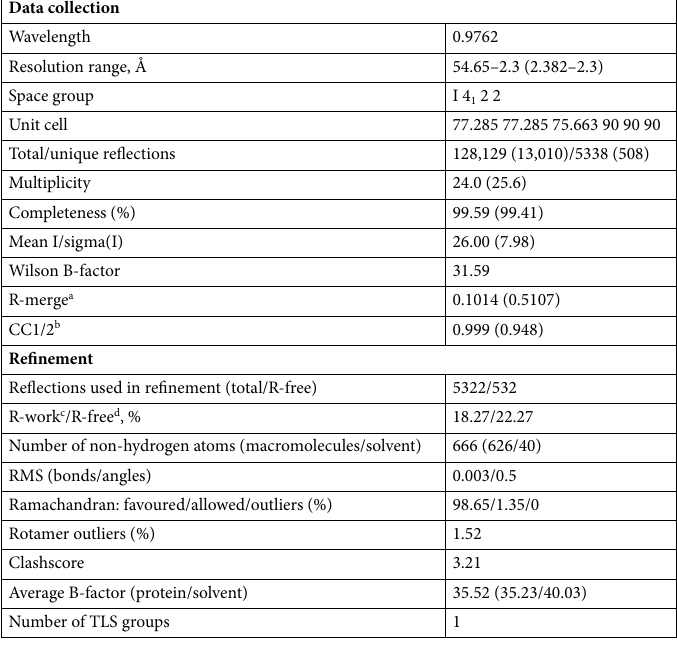
Table 1. Data collection and refinement statistics. Data collection statistics for the highest-resolution shell are shown in parentheses. a R merge = � hkl (cid:31) i | I i ( hkl ) − � I ( hkl ) �| / (cid:31) hkl (cid:31) i I i ( hkl ) , where I i (hkl) is the intensity of the measured reflection (hkl) and n denotes multiplicity. b CC 1/2 is the correlation coefficient of the